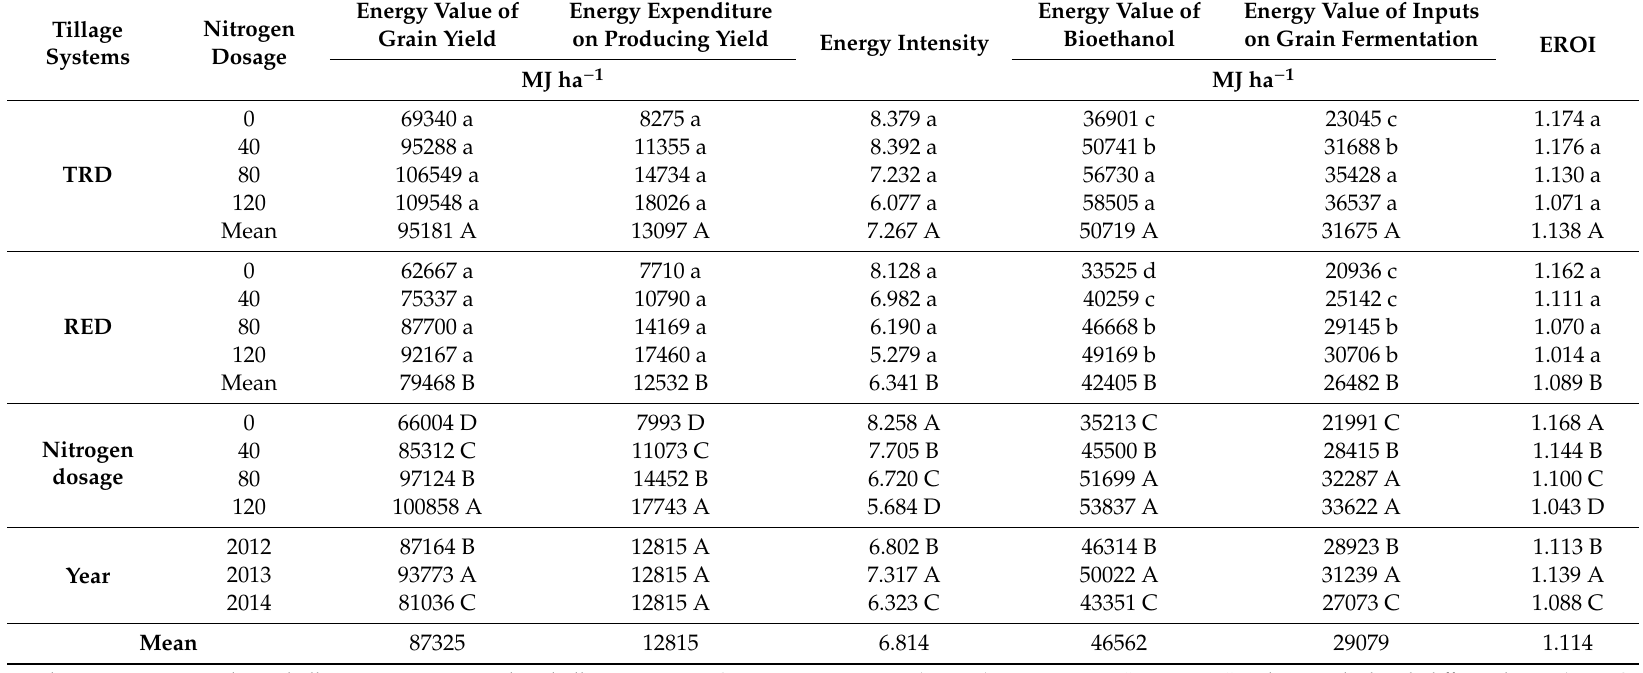
Table 6. Energy intensity in the production of spring Triticale and